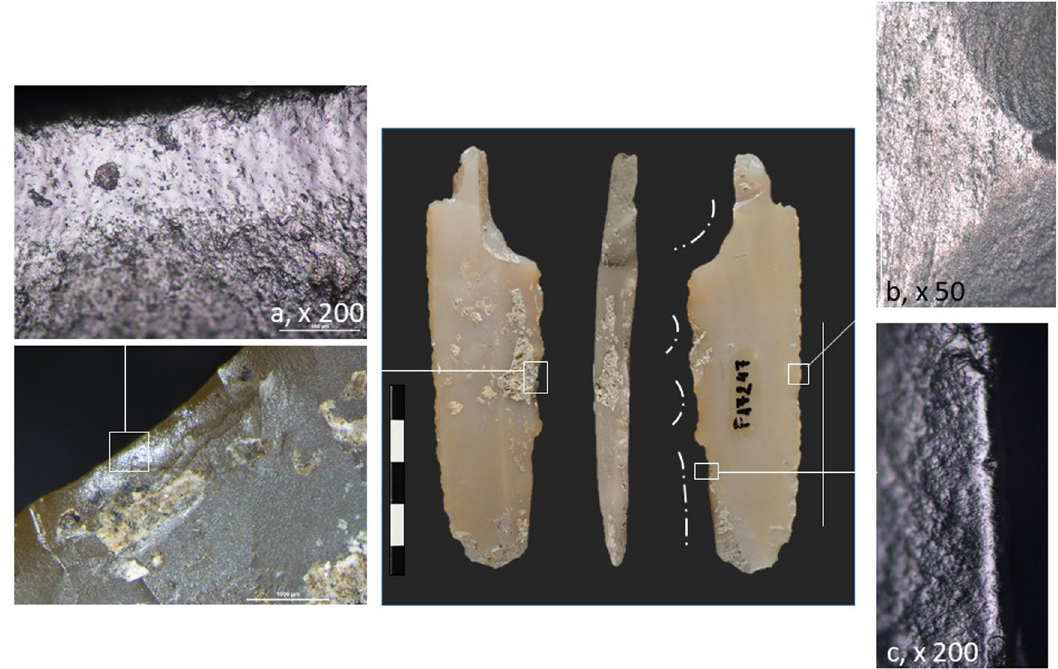
Figure 4: Central Blade ( « débitage optimum », rhythm C2 ) , obtained by ( lever ) pressure, used to scrape soft plant ( a, non - contact surface ) , to cut abrasive material ( b ) and scrape hard organic material ( c )